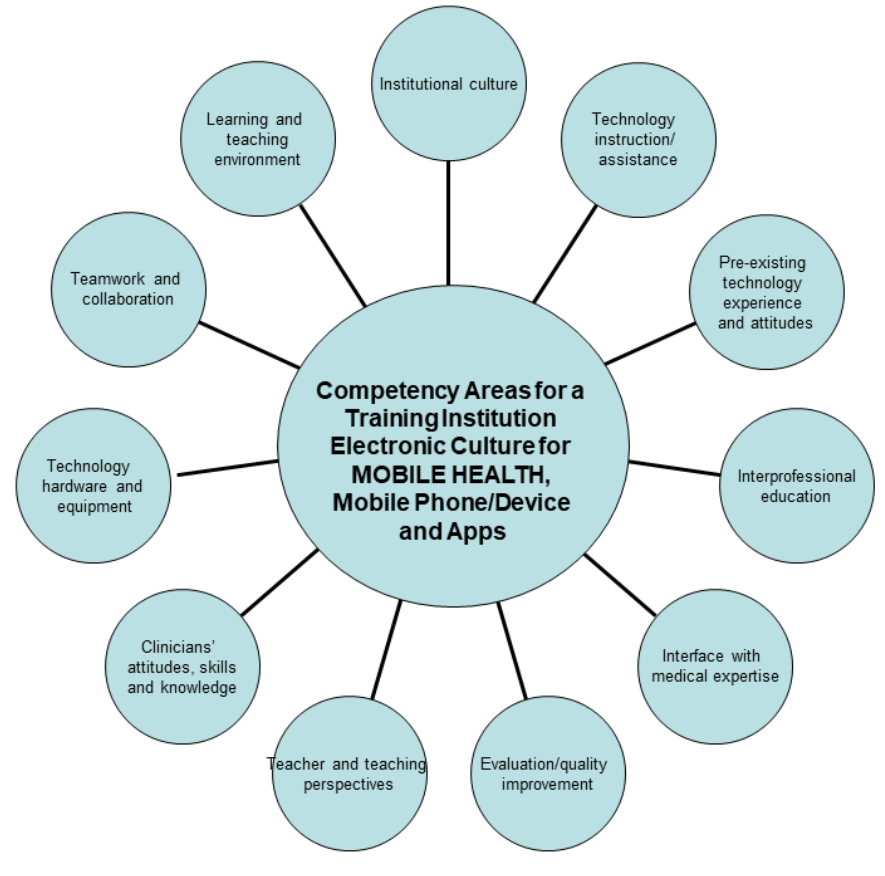
Figure 3. The relationship between patient care needs based on acuity and information technology